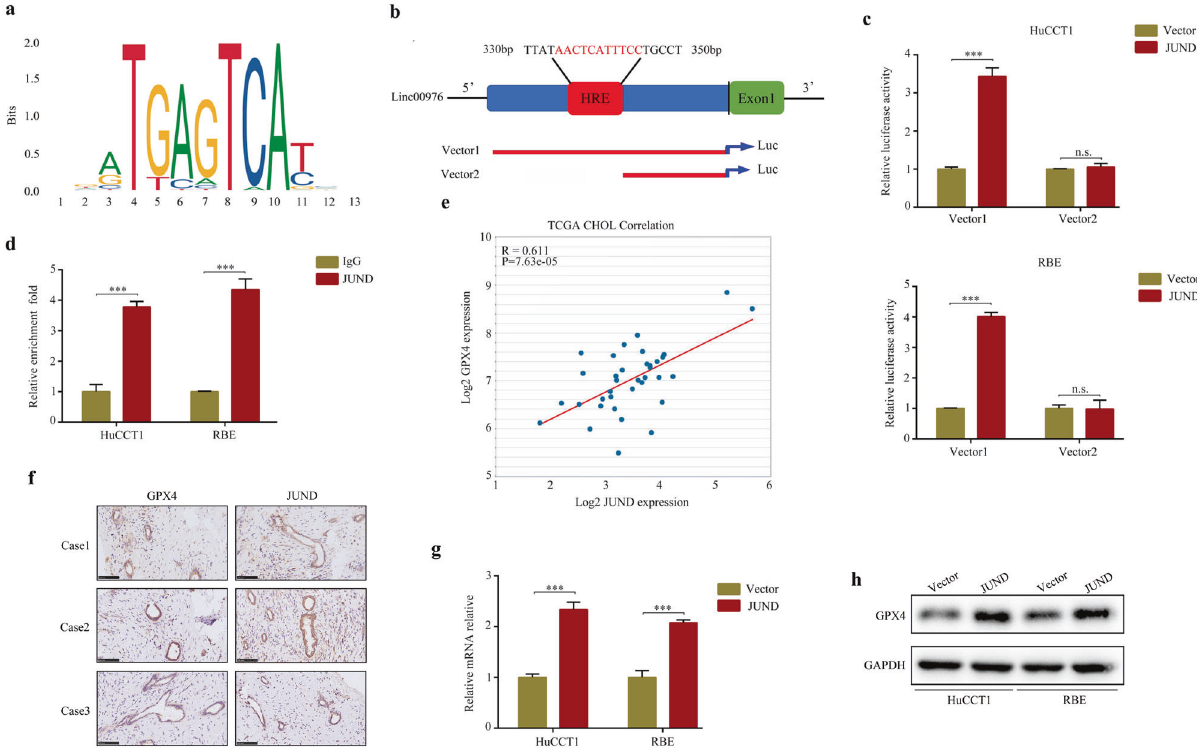
Fig. 8 JUND regulates the expression of linc00976 by binding to the JUND promoter. a The motif of JUND. b The binding site in the promoter of linc00976 is shown. c CCA cells were transfected with either a full ‐ length or truncated linc00976 promoter ‐ pGL3 reporter vector and further cultured, either with or without JUND plasmid. After 48 h, luciferase activity was measured using the dual ‐ luciferase reporter assay system. d ChIP assays with anti-JUND antibody verifying the binding between JUND and response element of the linc00976 promoter. e